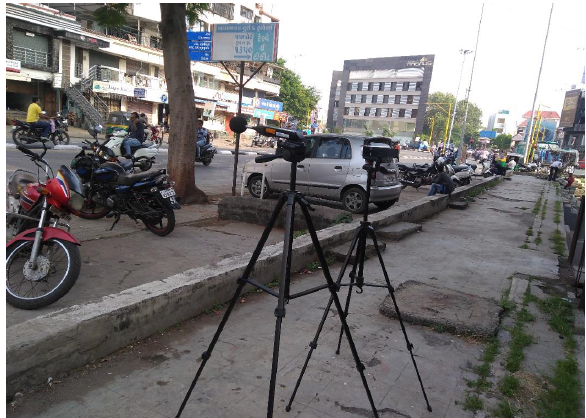
Figure 6: View of location 4-B